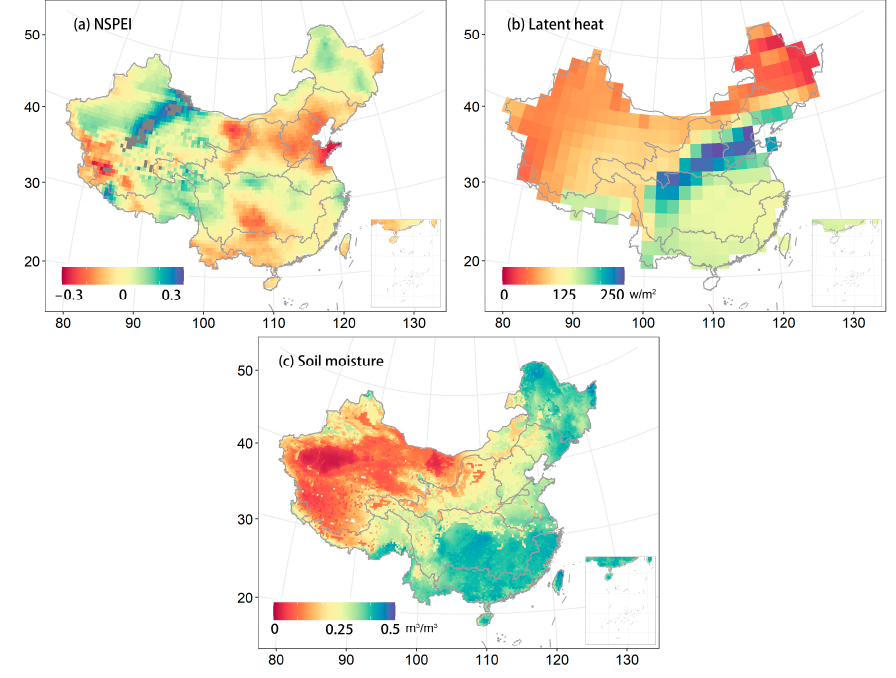
Figure 1. Spatial characteristics of annual SPEI, LHF and soil moisture.